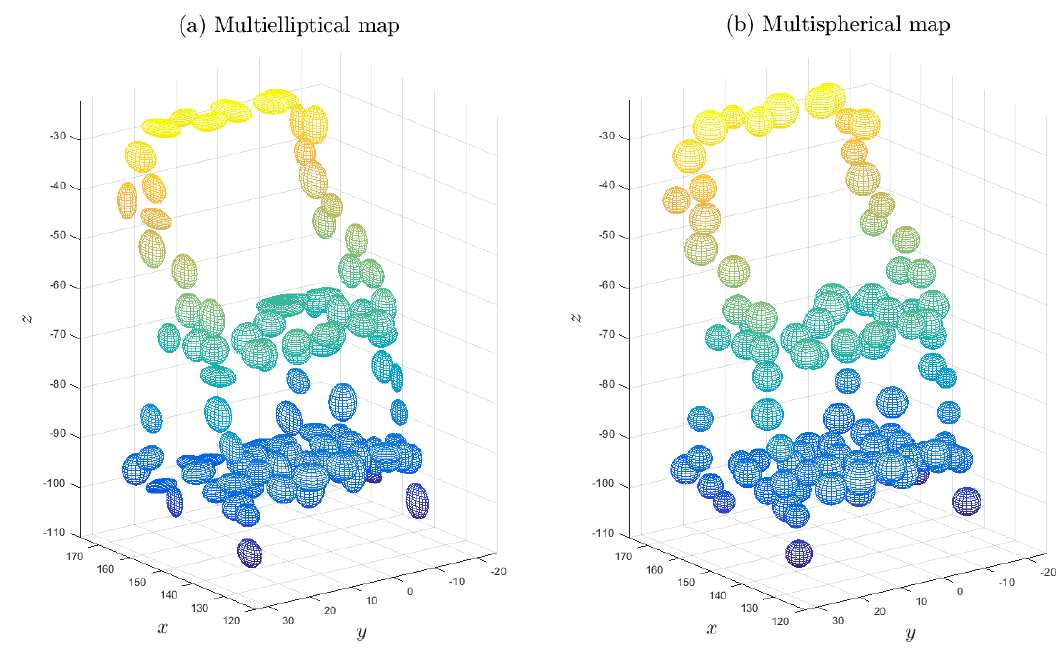
Figure 12. Maps of experiment 10.